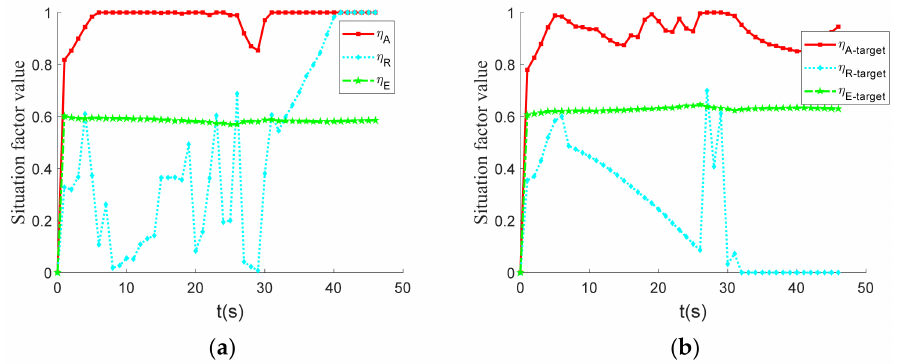
Figure 16. Maneuver situation factor change curve. ( a ) UCAV; ( b )